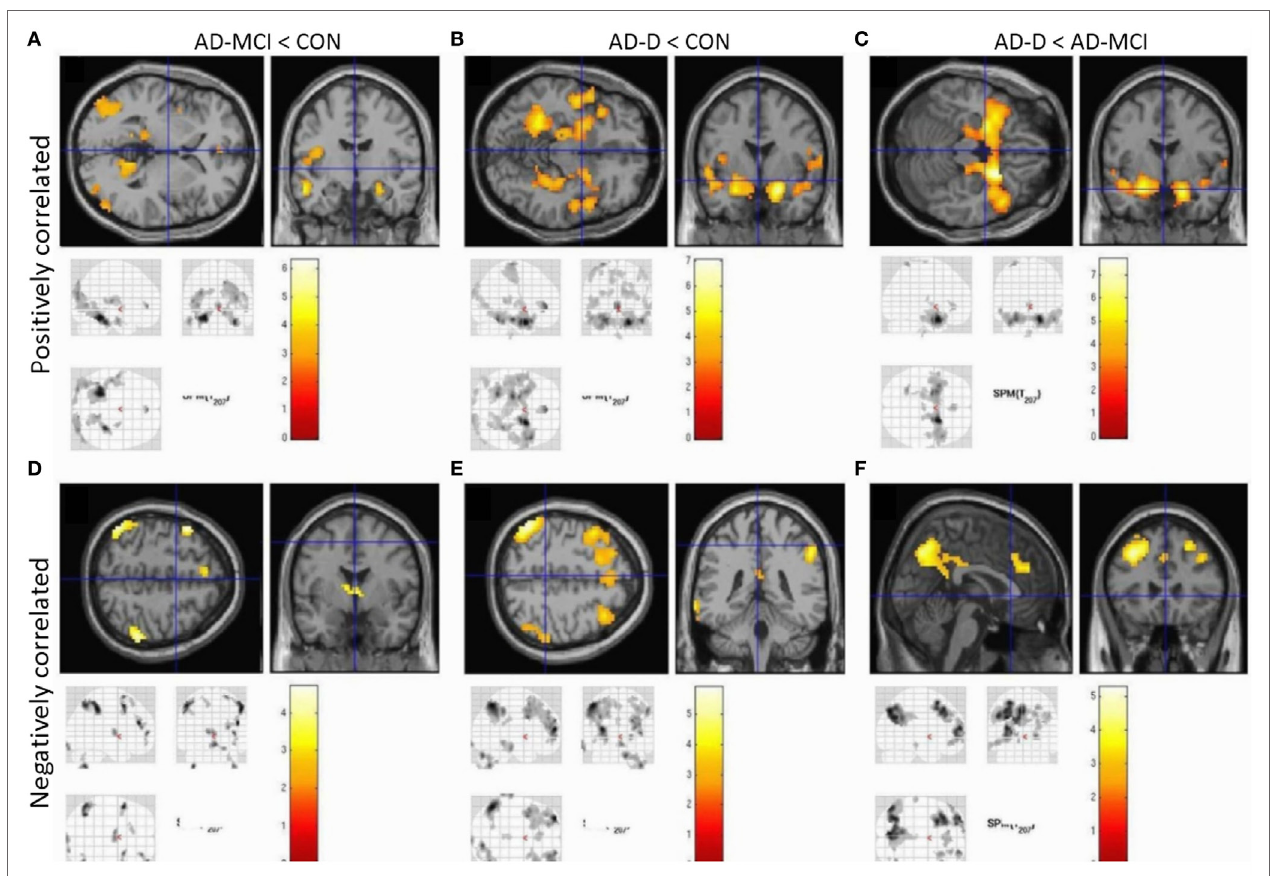
FigUre 3 | group contrasts of amygdala whole-brain functional connectivity, taking volumetric amygdala differences into account by including individual VBM scores as covariates into anOVa models . Upper row (a–c) shows positively correlated activity, lower row (D–F) anticorrelated activity. Columns code different group contrasts: (a,D) CON over AD-MCI; (B,e) CON over AD; (c,F) AD-MCI over AD-D. Bars represent T -values, p = 0.05, FWE corrected, cluster